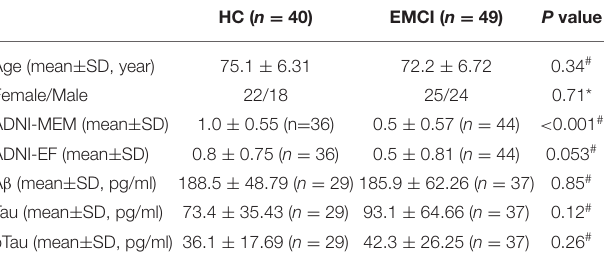
TABLE 1 | Demographics and clinical measures of the HC and EMCI